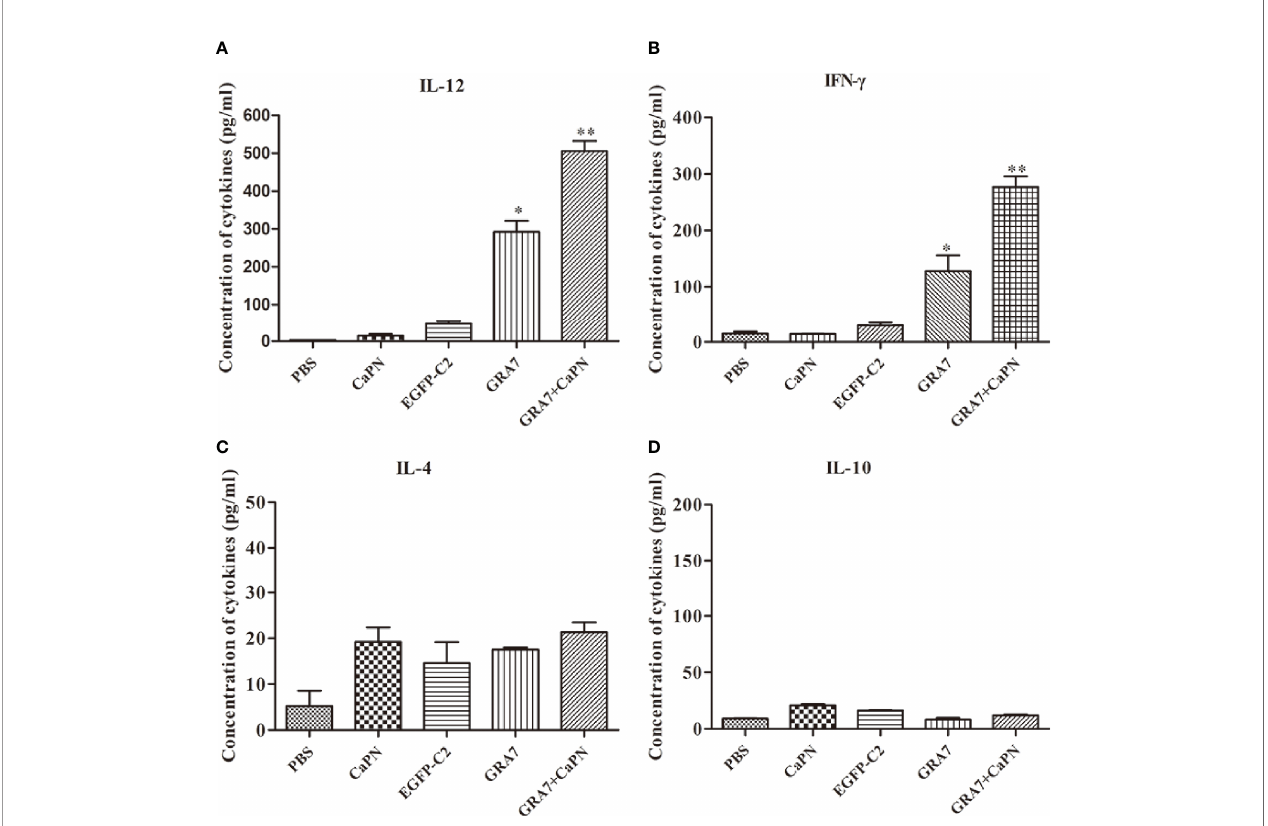
FIGURE 5 | Levels of cytokines produced by splenocyte culture supernatants. (A) Production of interleukin (IL)-12 collected from splenocyte supernatants after culture for 96 h. (B) Detection of interferon (IFN)- g collected from splenocyte supernatants. (C) Production of IL-4 after culture for 24 h. (D) Production of IL-10 after culture for 72 h. * P < 0.05, ** P <